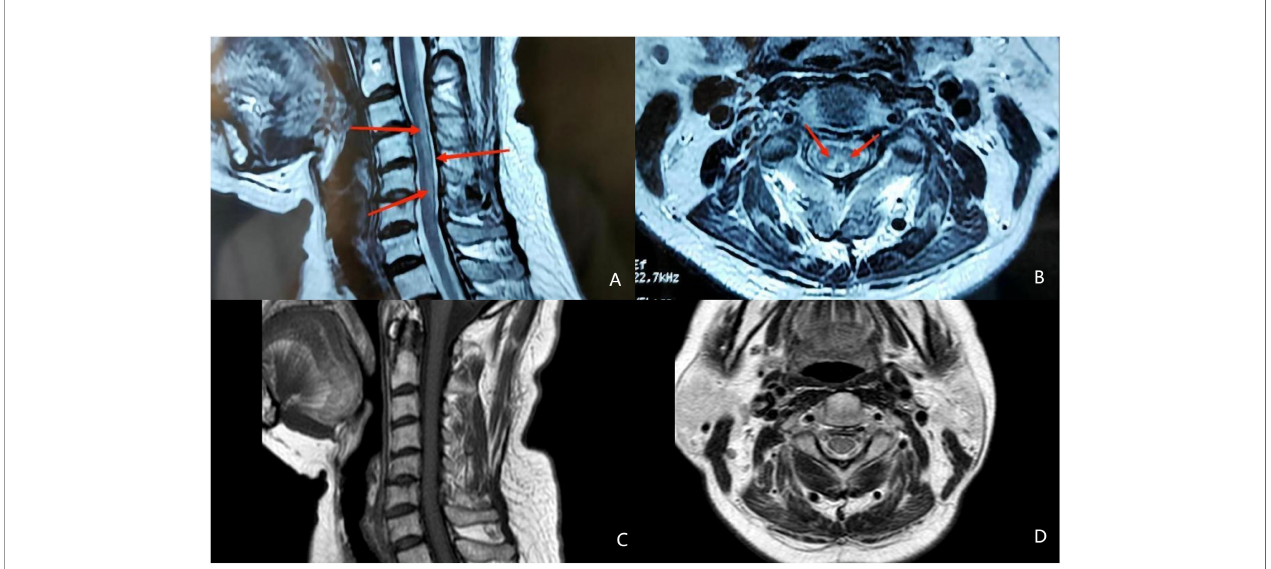
FIGURE 1 | Magnetic resonance image (MRI) fi ndings in the spinal cord. (A) abnormal longitudinally extensive T2 weighted hyperintensities involving the posterior columns (the red arrow) (B) inverted V or “ rabbit ears ” sign on cervical spinal (the red arrow). (C) abnormal hyperintensities involving the posterior columns disappeared in MRI after treament. (D) recovered MRI image on cervical spinal after